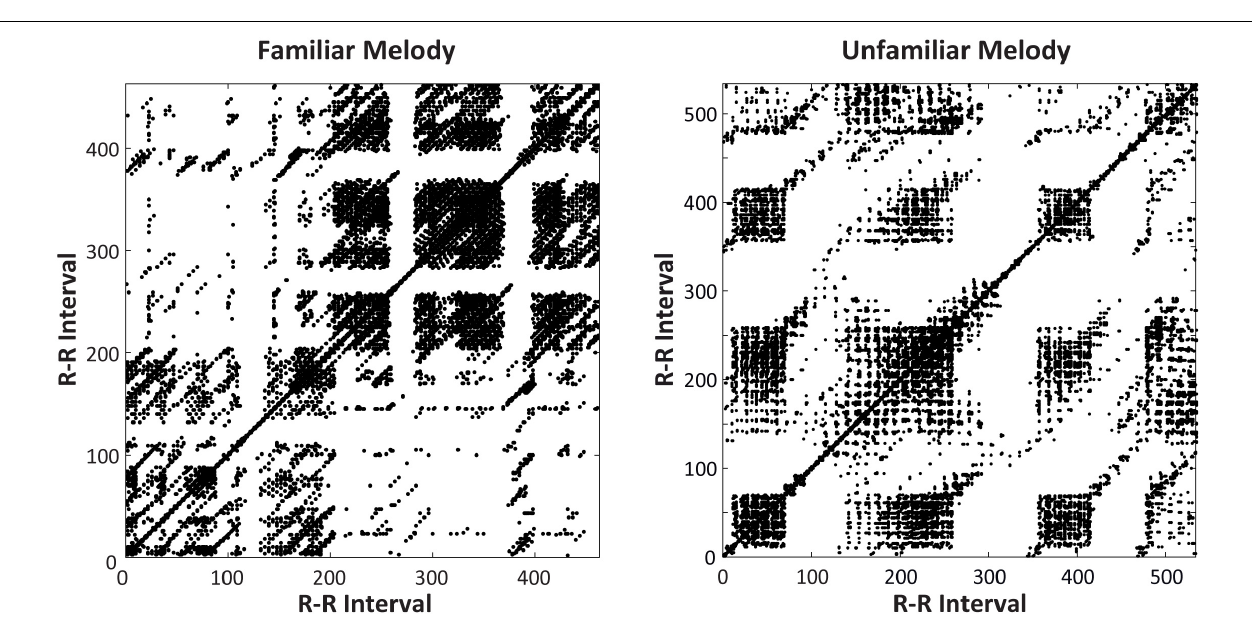
FIGURE 6 | Recurrence plots for a single participant’s heartbeat series (RR intervals, in ms, plotted on x - and y -axes) at 09 h. Plots include 5-mine Baseline rest period (left) and Unfamiliar melody performance (right) . The melody performance showed greater determinism (%DET = 58.88) than did the Baseline Rest (%DET = 39.62).